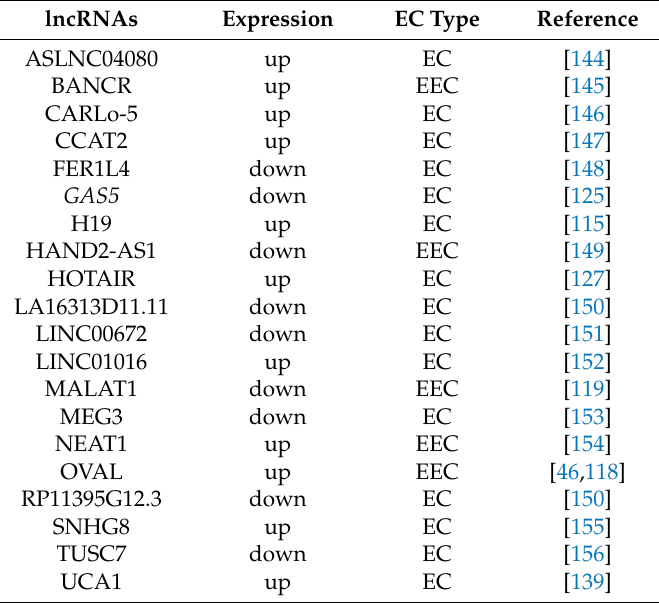
Table 3. lncRNAs differentially expressed in EC